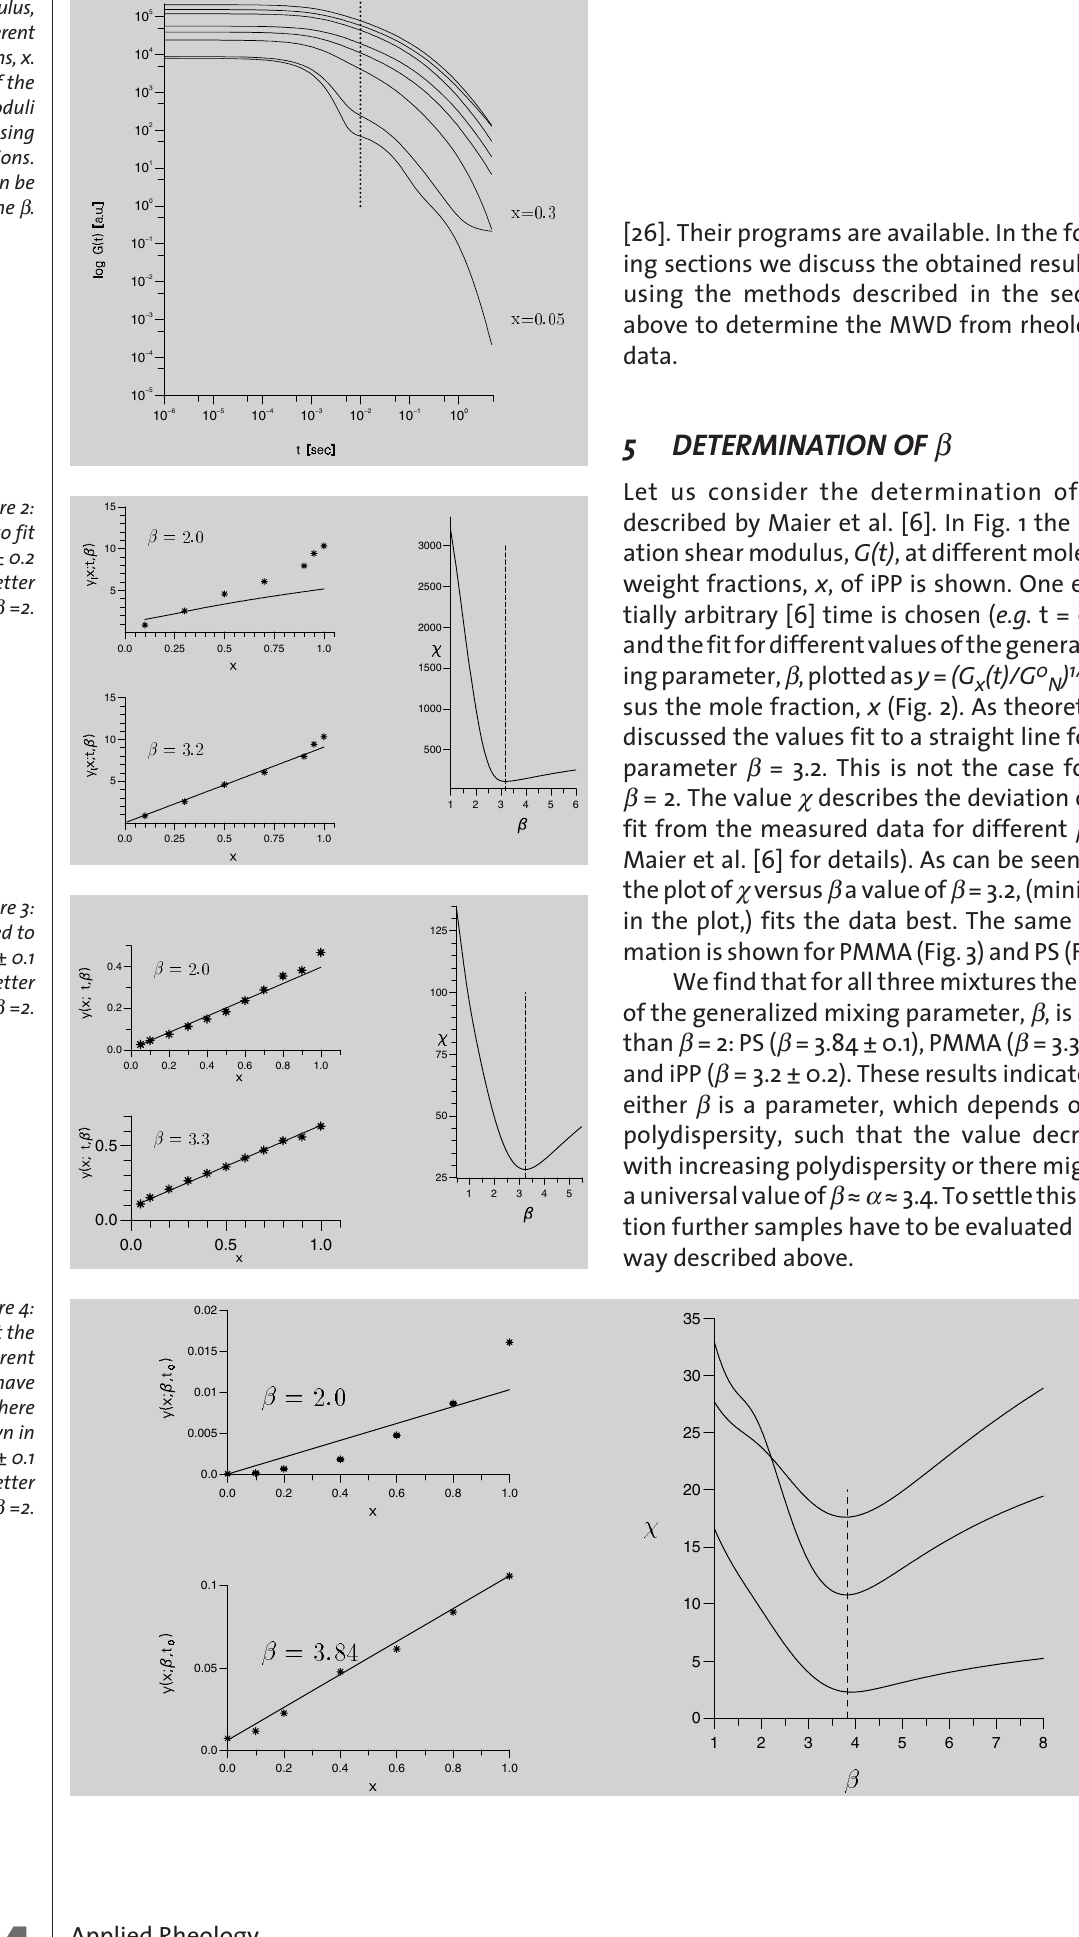
Figure 1: iPP: The relaxation modulus, G(t), is shown for different molecular weight fractions, x. The absolute values of the relaxation shear moduli decrease with decreasing molecular weight fractions. The time t = 0.01s can be used to determine β .